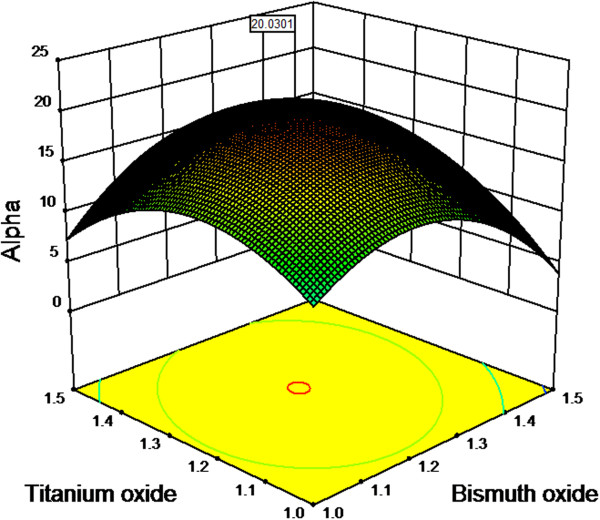
The effect of Bi2O3 and TiO2 on alpha that simultaneously presented by 3D response surface plot, the maximized alpha was 20.031.